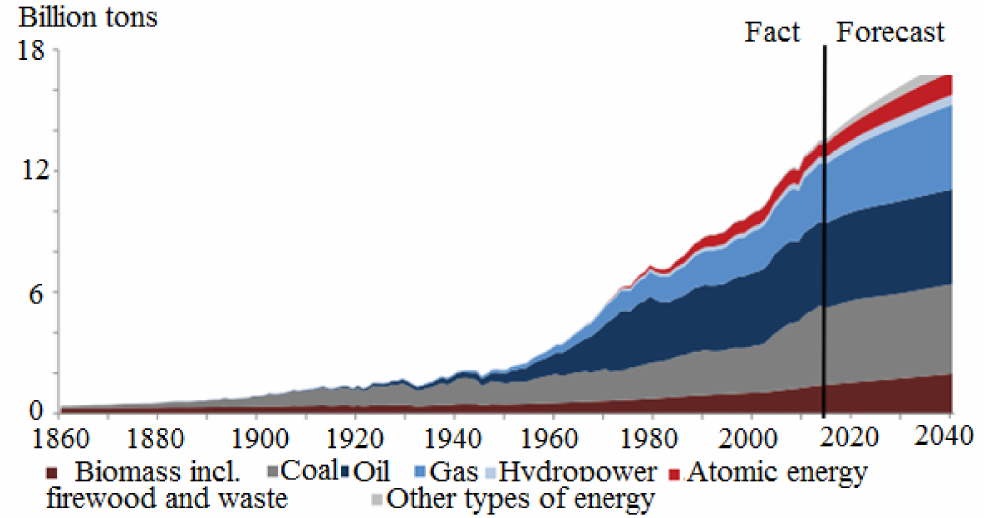
Figure 2. Russian electricity consumption of nonconventional renewable energy resources, 1860–2040